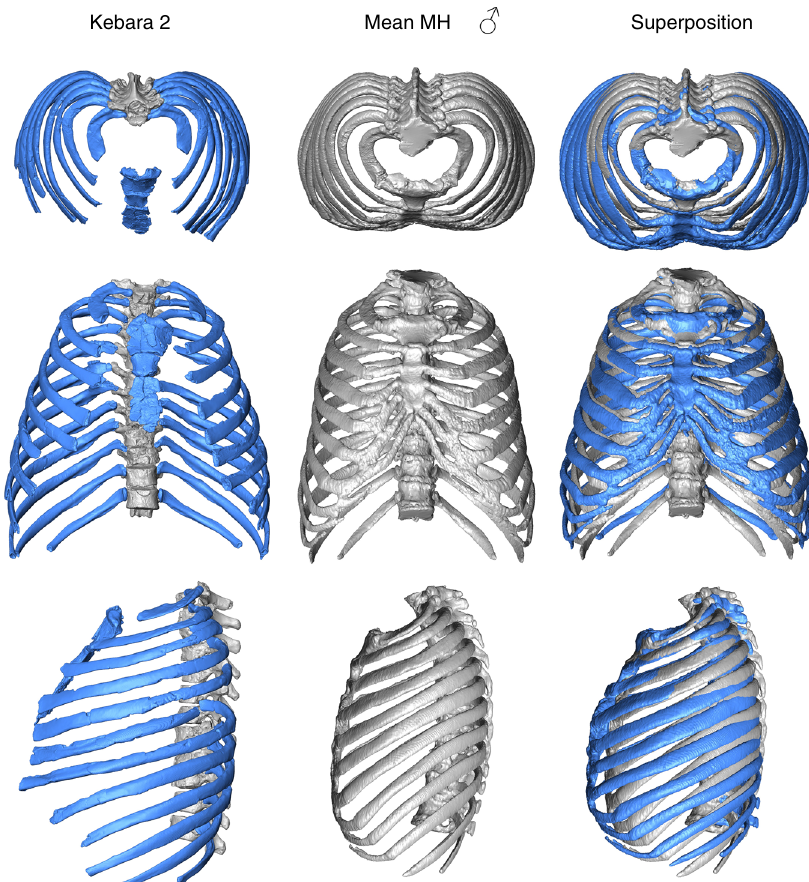
Fig. 2 Comparison of the Kebara 2 (K2) thorax (left column; see legend in Fig. 1 for color explanation) to the modern human male sample (in gray; middle column) and superposition of the two morphologies (in blue, Kebara 2; in gray, the modern human sample male mean; right column) in cranial (top row), ventral (middle row) and left lateral (lower row) views. In the cranial view, the invagination of the K2 spine into its thorax is noticeable. In ventral view, the relatively (and absolutely; see Table 1) wider thorax of Kebara 2 compared to modern humans is appreciable. In lateral view, K2 shows relatively larger antero-posterior mid-thorax and straighter shafts of the rib, while modern humans show more caudally curved ribs sternal to the posterior angle. In the third column the same template has been used in order to represent the modern human male mean (gray) and the K2 morphology. In the superposition, both the modern human male thorax and the K2 thorax scaled to the same centroid